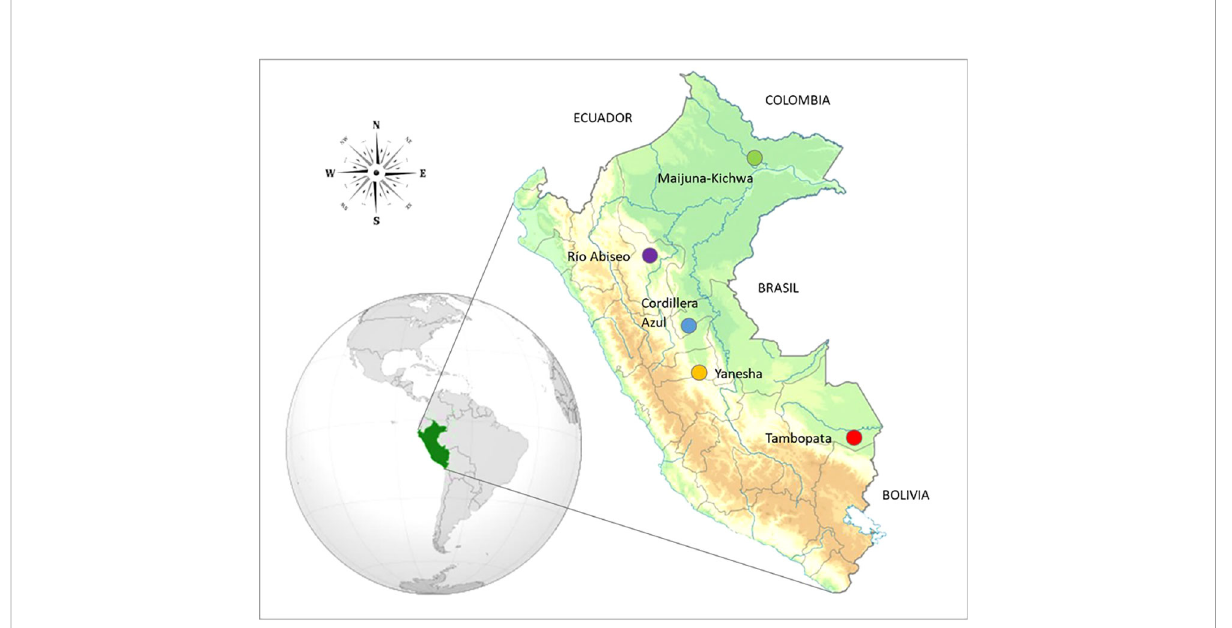
FIGURE 1 Map of Peru with coloured dots indicating the fi ve regions studied in Western Amazonia. Top to bottom: Maijuna-Kichwa Regional Conservation Area, R ı ́ o Abiseo National Park, Buffer Zone of Cordillera Azul National Park, Yanesha Comunal Reserve and Tambopata National